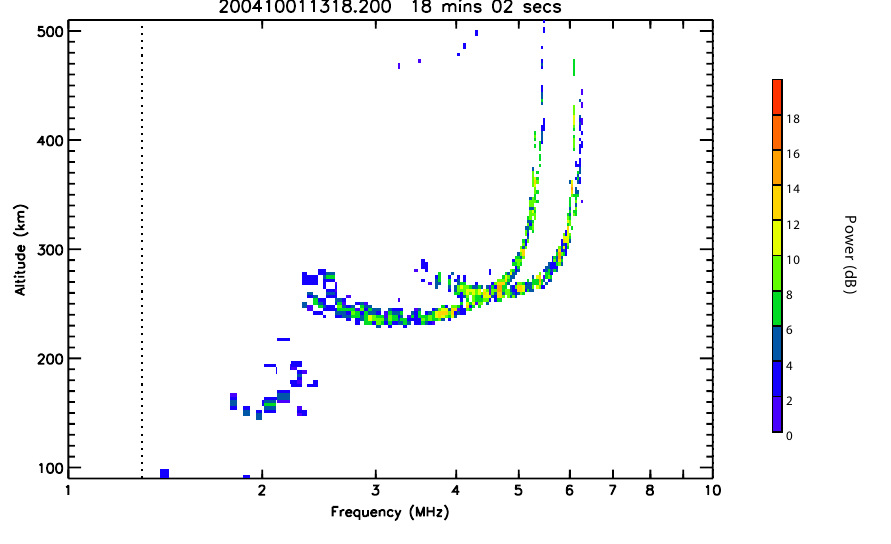
Fig. 18. Svalbard ionogram for 13:18 UT, 1 October